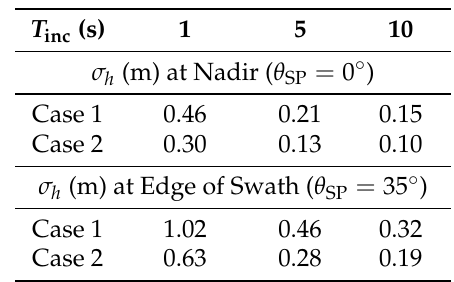
Table 3. Summary of the altimetric precisions for different cases at nadir and the edge of swath. Case 1: Without IM, Case 2: With